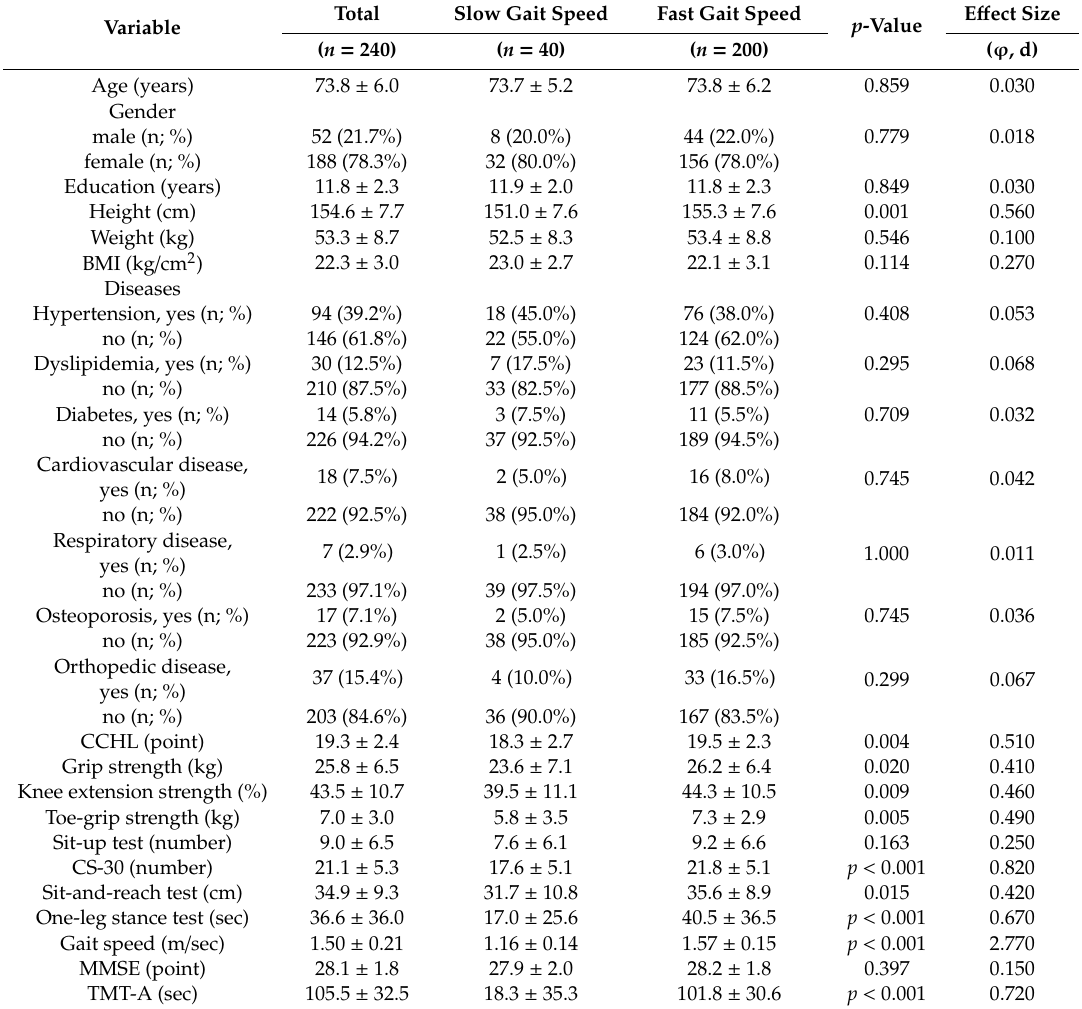
Table 1. Subjects’